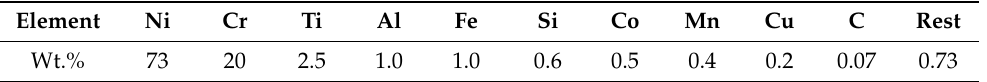
Table 4. Chemical composition (wt.%) of processed nickel alloy NiCr20TiAl. Element